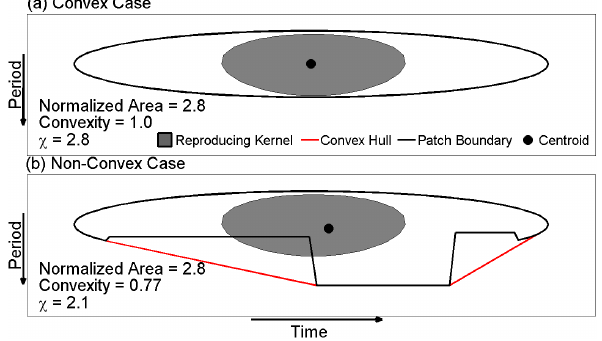
Figure 5. (a) An idealized convex pointwise significance patch whose boundary is indicated by the black contour and whose cen- troid is indicated by the black dot. For reference, the reproducing kernel associated with the areawise test is shown, which is indicated by gray shading. In this case, the reproducing kernel lies entirely in- side the patch. The convexity, normalized area, and χ are displayed on the bottom left corner. (b) Same as (a) except the area of the convex hull (red curve) is not equal to the area of the patch and the reproducing kernel is unable to fit entirely inside the